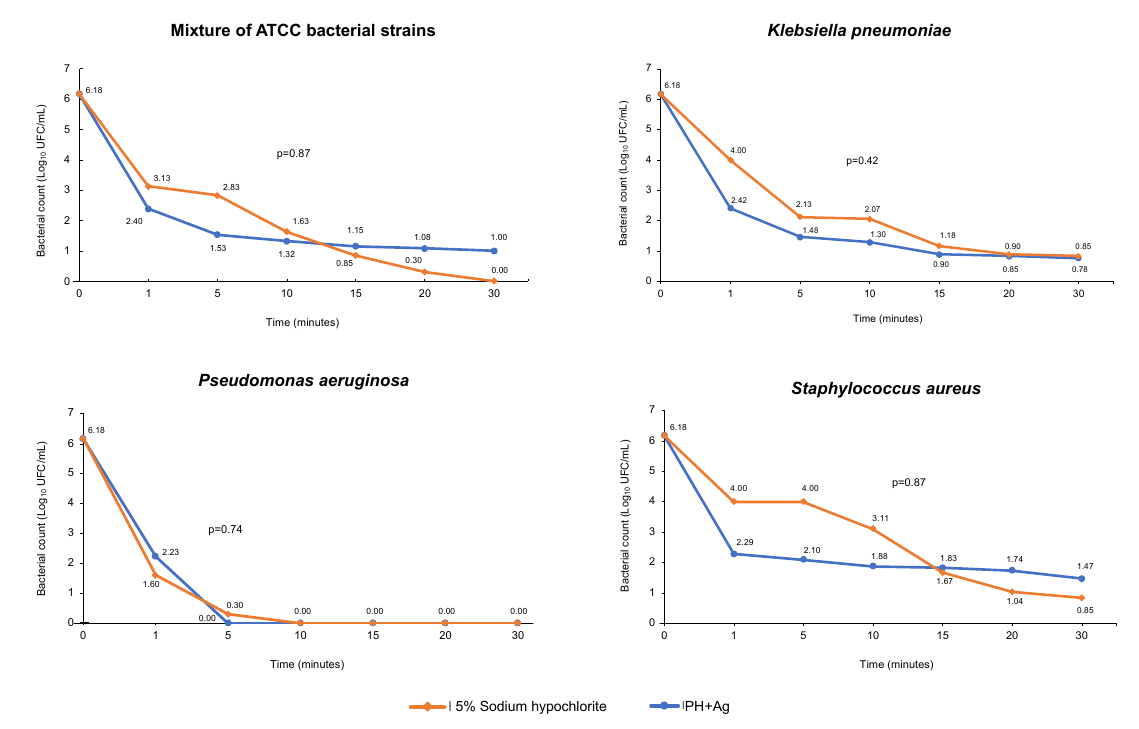
Figure 1. Death curves of the bacterial mixture of ATCC strains and resistant clinical isolates of K. pneumoniae , P. aeruginosa , and S. aureus exposed for 30 min to HP + Ag. The bactericidal activity of HP + Ag against MDRPa clinical isolates over time